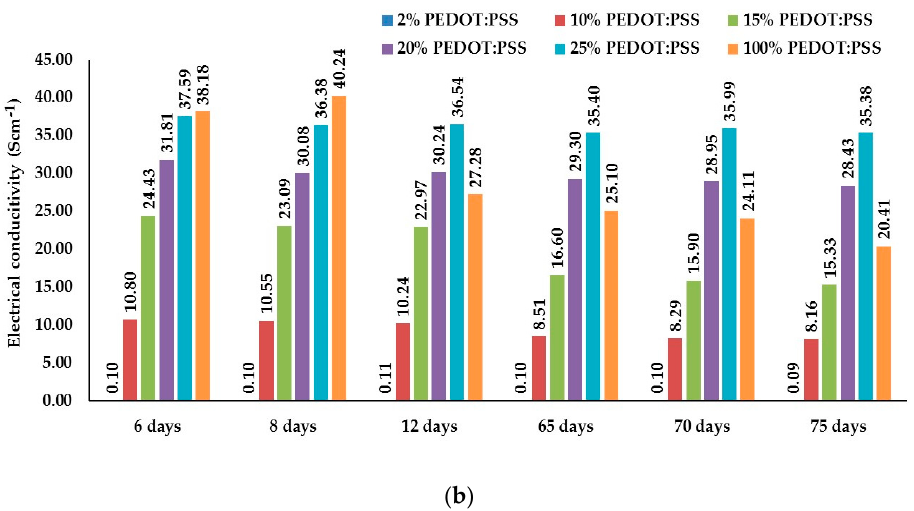
Figure 6. Electrical conductivity (S cm − 1 ) of A/C and B/C dry films in a period of 75 days: ( a ) A/C dry films, ( b ) B/C dry films.